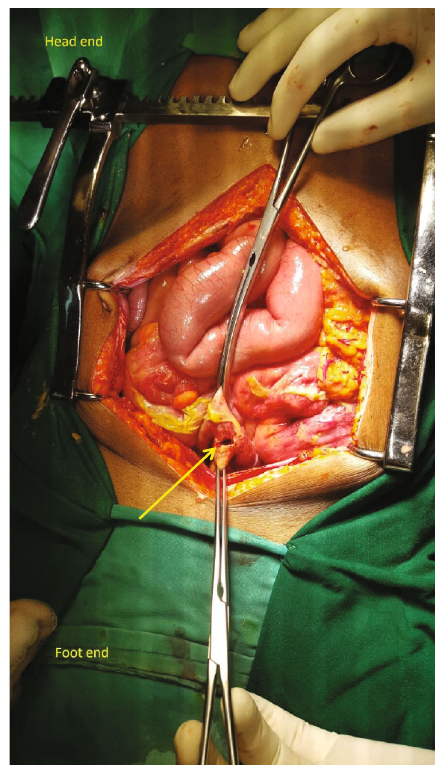
Figure 4: Intraoperative image: yellow arrow shows the perforation of the antemesenteric border of the rectosigmoid